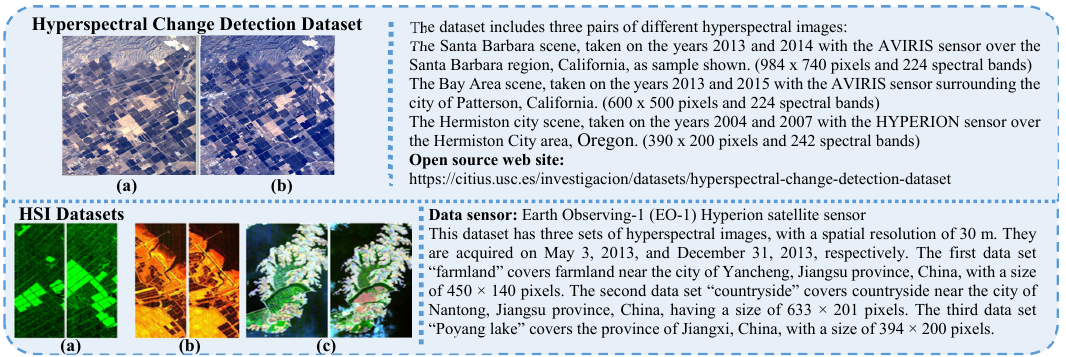
Figure 7. Dataset introduction of hyperspectral images.